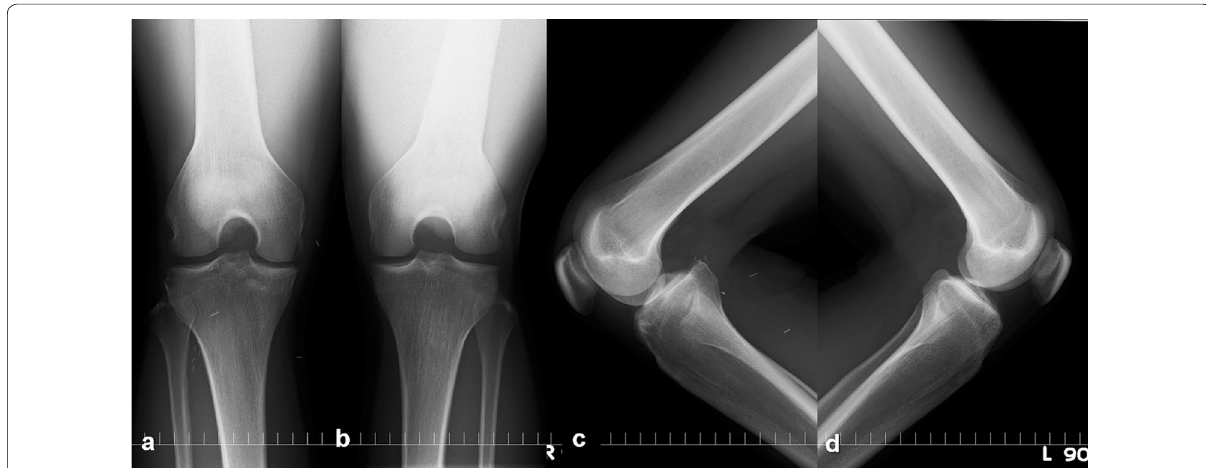
Fig. 4 Postoperative radiograph (same patient as in Fig. 2). a , b Radiograph taken 4 years after primary repair showing no significant change in osteoarthritis; c , d posterior sag view of bilateral knee. Radiograph of right knee shows posterior laxity of 13 mm. This patient does not need further surgery and has returned to recreational baseball play without